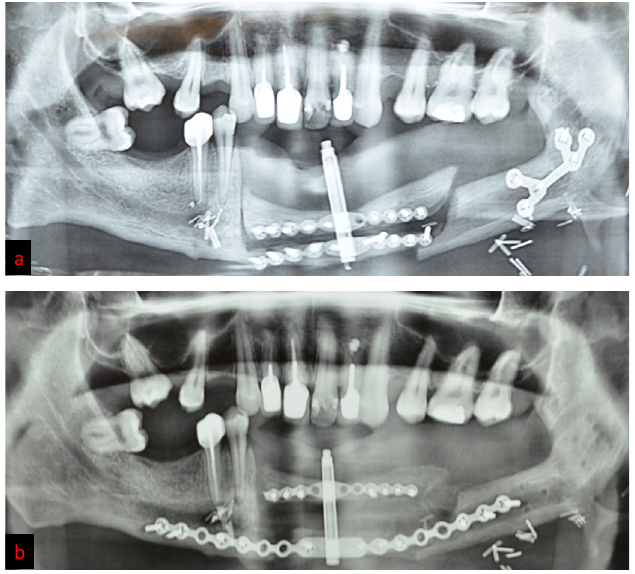
Fig. 6. Fracture of the basal bone on either side of the distraction site (6a), fi xed with a longer basal plate of a new distractor device